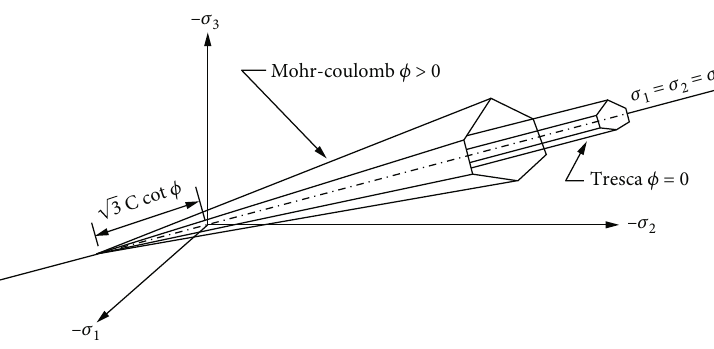
Figure 1: Mohr-Coulomb yield surface in principal stress